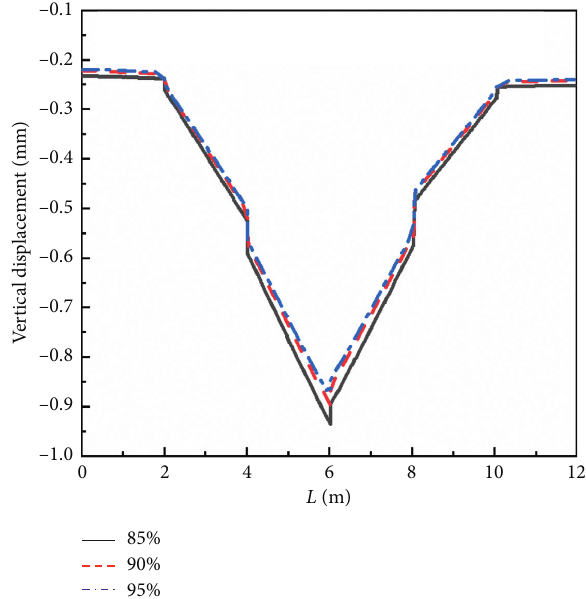
Figure 21: Longitudinal vertical displacement of the